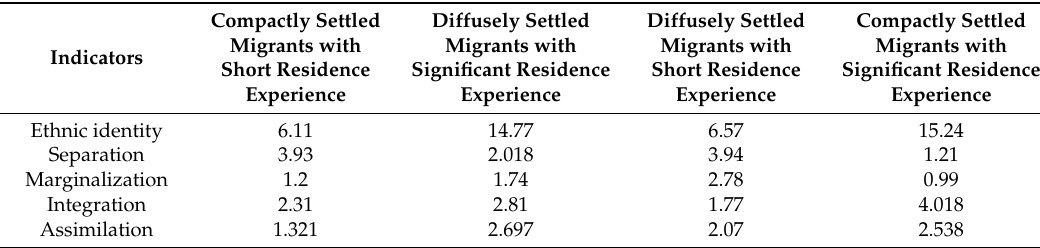
Table 1. The group mean for ethnic identity attributes and acculturation